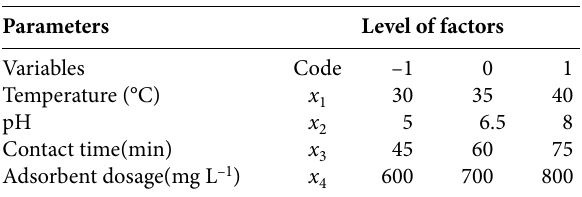
Table 1. Factors and level of various parameters of BBM design for As(V) adsorption Parameters Level of factors Variables